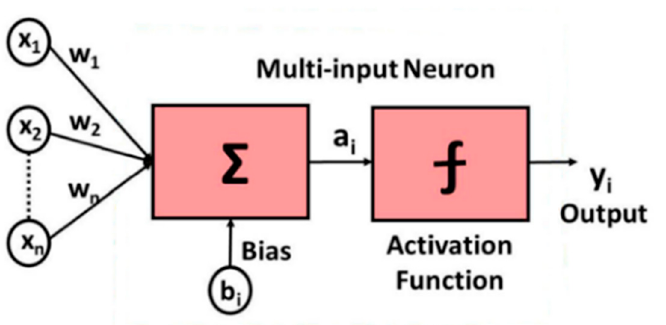
Figure 3. The flow chart of the surrogate model.